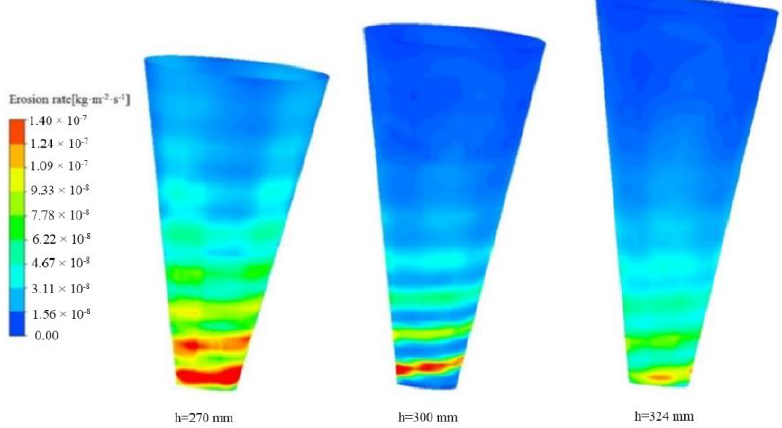
Figure 16. Erosion contour for different cone lengths.